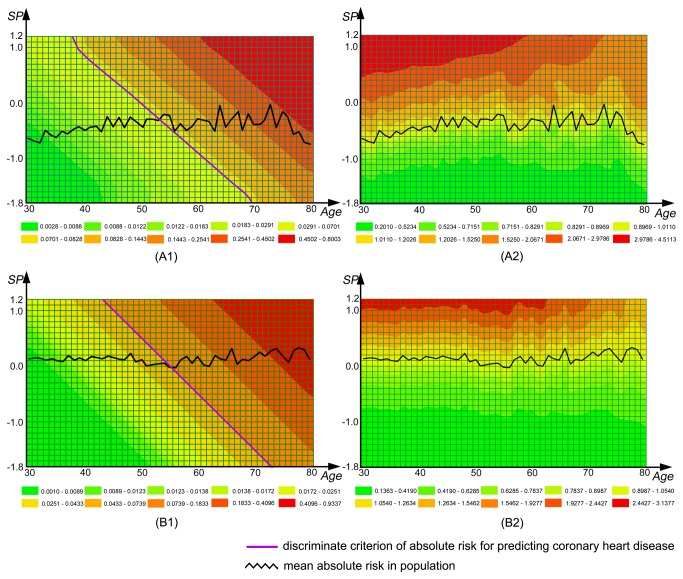
The 5-year risk matrix for risk appraisal of coronary heart disease by gender.A1 and B1 are absolute risk matrix of male and female respectively. A2 and B2 are relative absolute risk matrix of male and female respectively. SP, synthetic predictor.For male: SP = 0.2226NAFLD + 0.0749BMI + 0.0081SBP + 0.0103DBP - 0.0011SUA + 0.0422FBG - 0.0863TC - 0.0920TG - 0.6562HDL-C + 0.0090LDL-C + 0.0045WBC count + 0.0065ALT + 0.0009GGT - 0.0076CREA - 0.0080Hb - 0.0312HCT + 0.8816. For female: SP = 0.3974NAFLD + 0.0267BMI + 0.0118SBP + 0.0168DBP + 0.0012SUA - 0.2089FBG - 0.1421TC - 0.3229TG - 0.9395HDL-C - 0.0544LDL-C - 0.0421WBC count - 0.0395ALT - 0.0461GGT + 0.0087CREA + 0.0022Hb - 0.0015HCT + 0.8739.